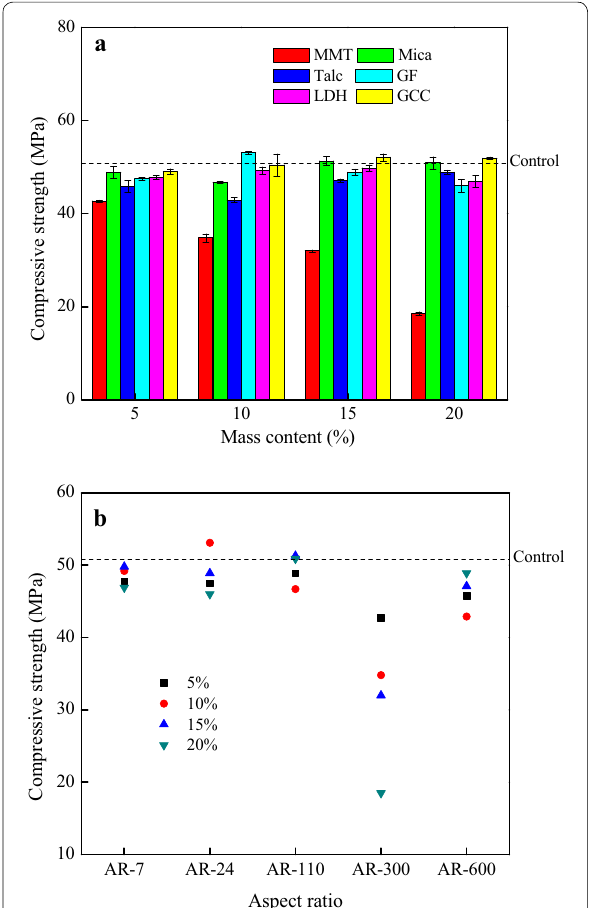
Fig. 2 Compressive strength of the modified EECM with different fillers. a Filler contents; b aspect ratios of fillers.